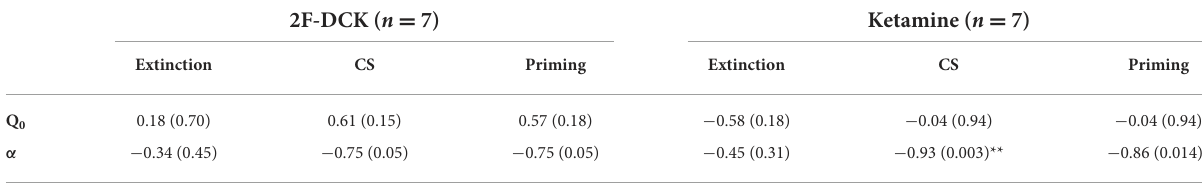
TABLE 1 The relationship of the Q 0 and α parameters with extinction, cue-induced, or drug-priming-reinstatement